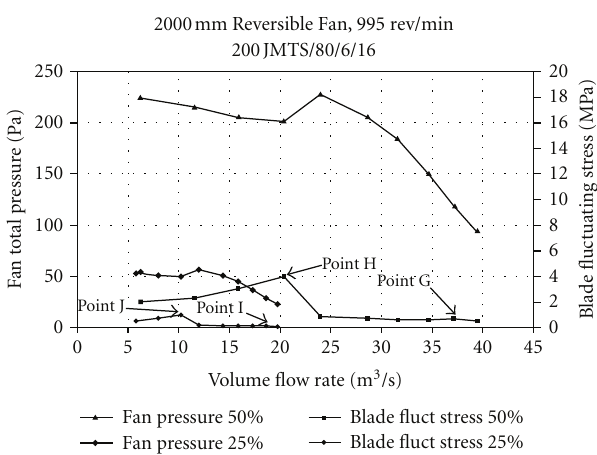
Figure 6: Stall characteristics of the test fan with a stalling blade stagger angle at half and quarter